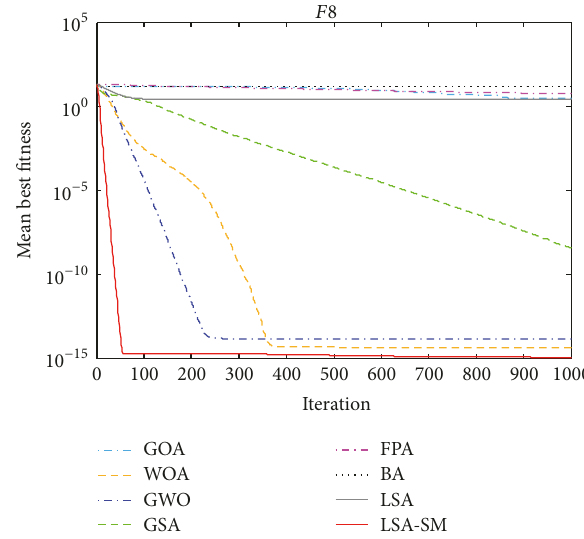
Figure 12: 𝐷 = 30 , convergence curves for 𝑓 08 .